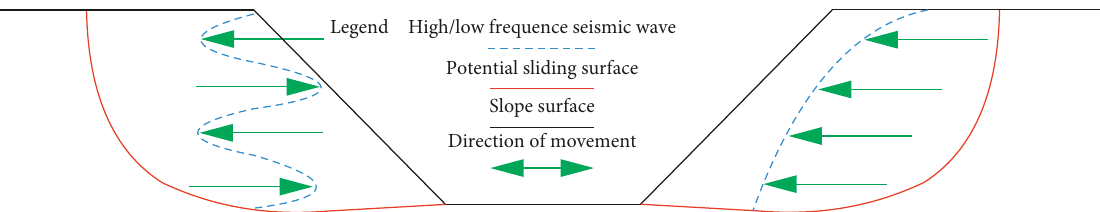
Figure 16: Effect of frequency of seismic wave on slope (modified from